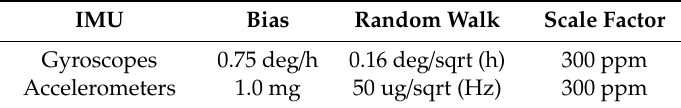
Table 3. The technical parameters of SPAN-FSAS.